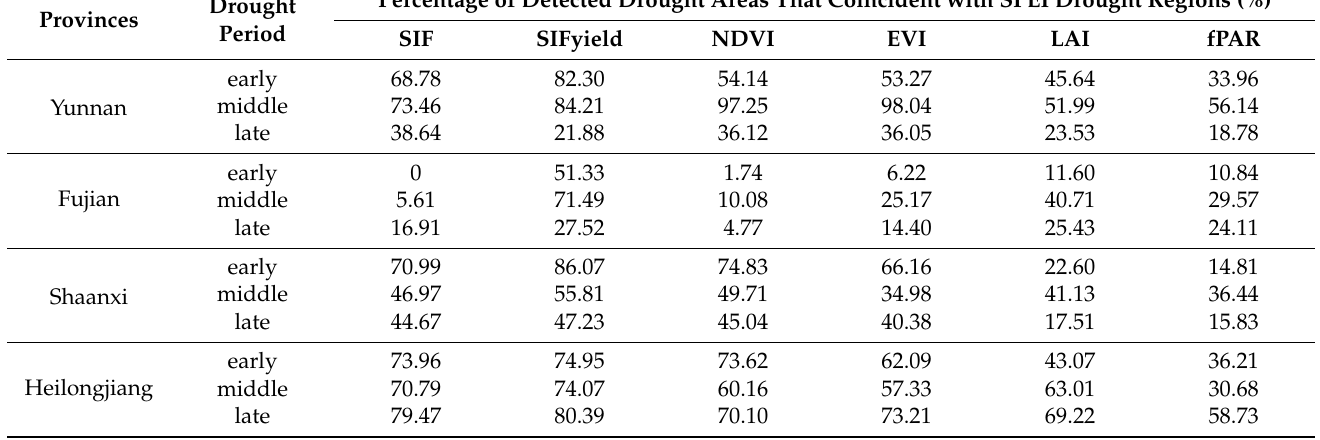
Table 3. SIF, SIFyield, NDVI, EVI, LAI, and fPAR correctly indicated the proportion of drought area in the early/middle/late drought period in four